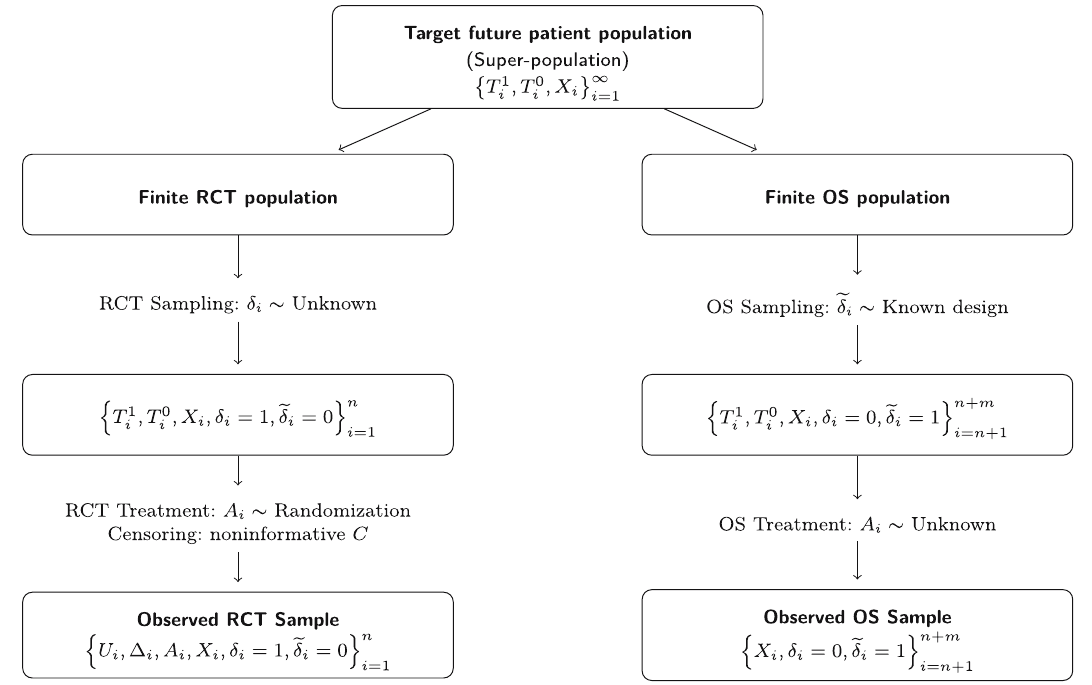
Figure 1: Illustration of the data structure of the RCT sample and the OS sample within the target super - population